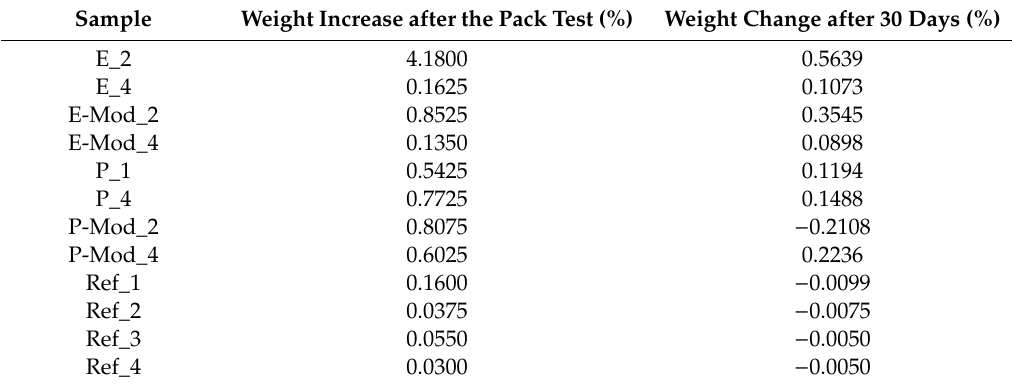
Table 4. Weight change measurements of the selected samples at the end of the pack test and after 30